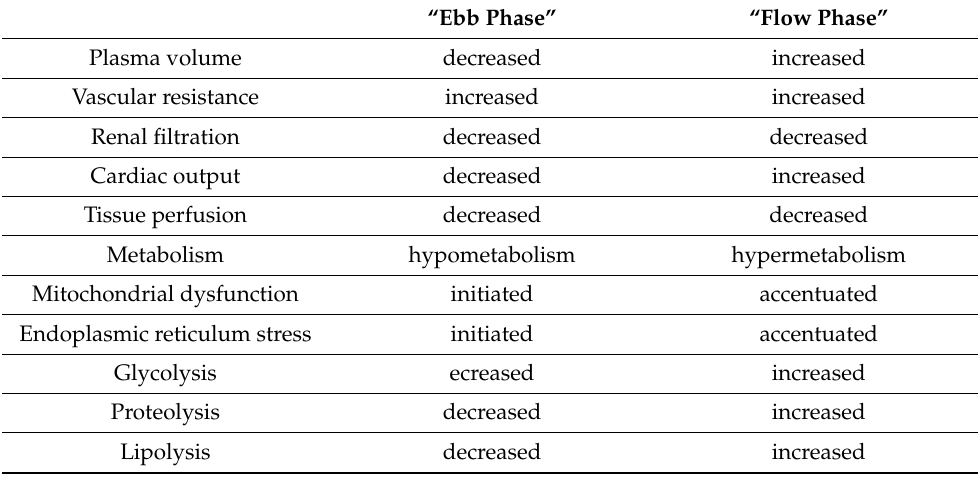
Table 1. Specific alterations in the “ebb” phase and in the “flow” phase in severely burned